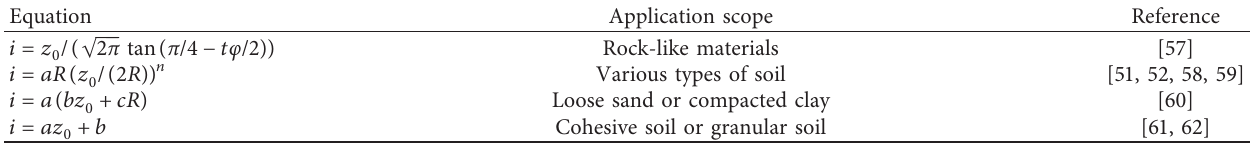
Table 2: Summary of equations for calculating settlement trough